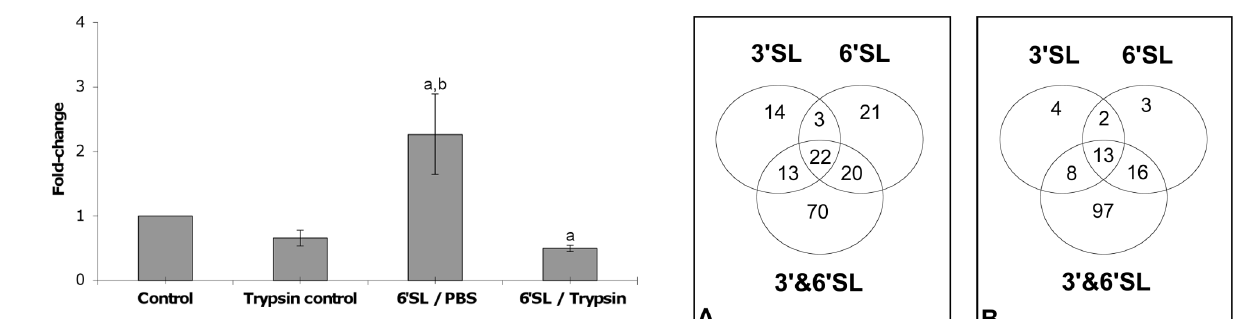
Figure 5. Differentially expressed transcripts following expo- sure to the three oligosaccharide treatments. (A) up-regulated transcripts (B) down-regulated transcripts. The cut-off point for inclusion was a p-value ,